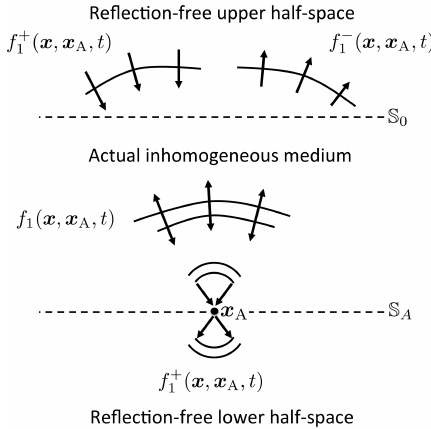
Figure 8. The focusing function f 1 ( x , x A ,t) in a truncated version of the actual